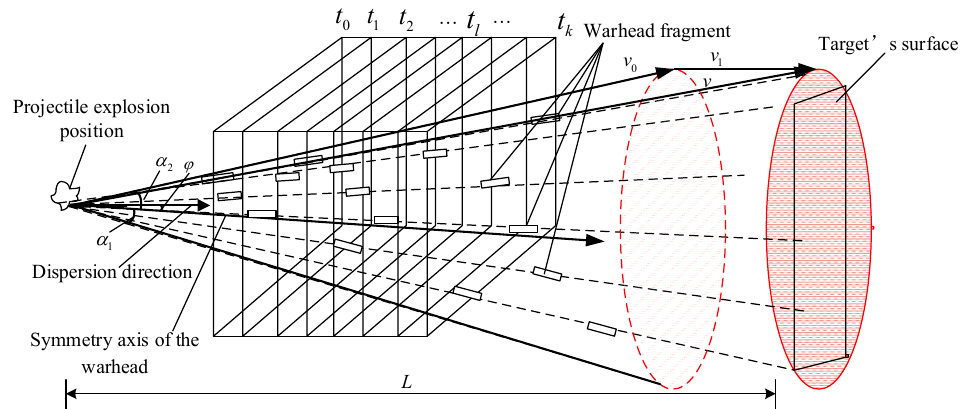
Figure 1. The schematic diagram of proximity explosion target under the intersection of projectile and target.